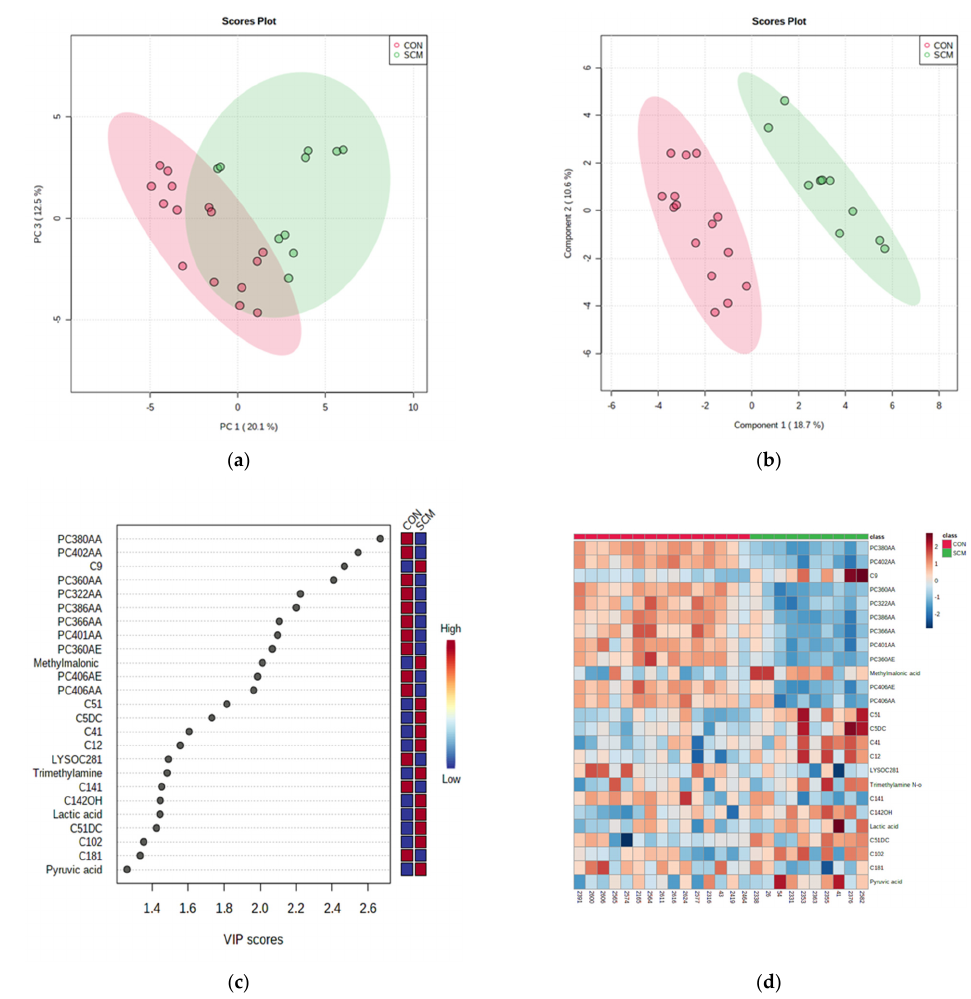
Figure 3. ( a ) Principal component analysis (PCA) and ( b ) PLS-DA (permutation test: p < 0.05) of 15 CON and 10 pre-SCM cows at − 4 weeks before parturition; ( c ) VIP plot of top 25 important features, and ( d ) heatmap of both samples and features based on PLS-DA to further investigate the identified variables.